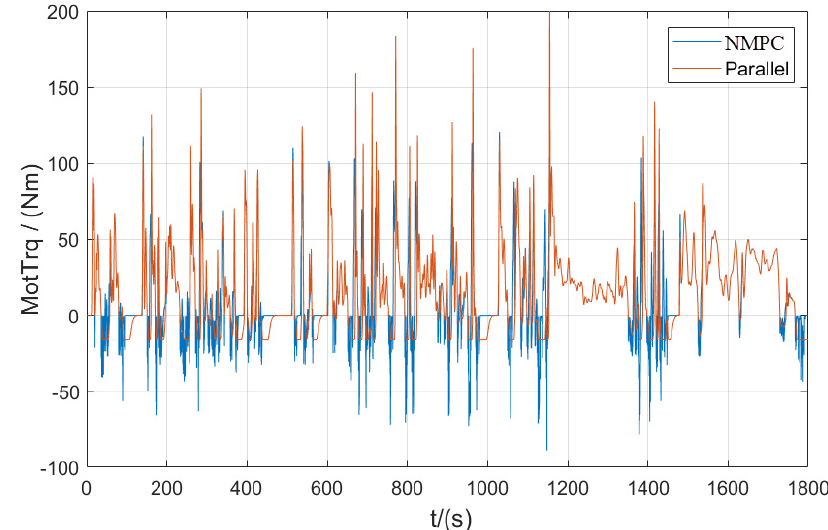
Figure 10. The motor braking torque curve.